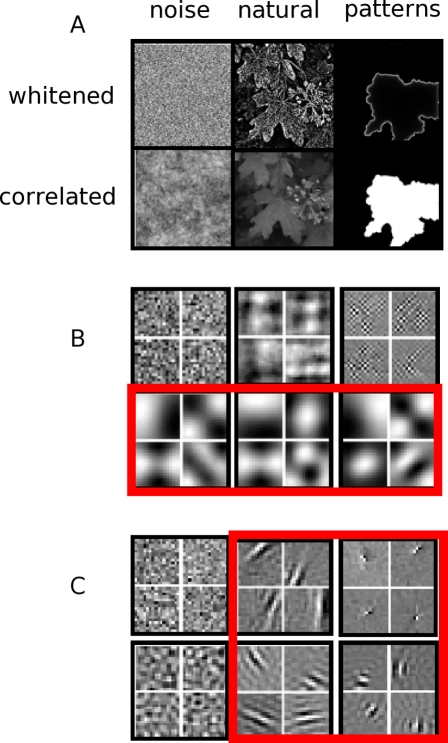
Information relevant to filter formation goes beyond simple, pairwise correlations.(A) Examples of training data for efficient coding. Whitened images were obtained by flattening an assumed 1/f slope in the Fourier amplitude spectrum. (B) PCA bases from each of the six data sets in (A). Note, algorithms which rely on pairwise correlations alone (also known as second order image statistics) only find structure for receptive field formation in correlated data [red rectangle] although much of the useful structure still visible in the decorrelated (“whitened”) images is not captured. Also note the receptive fields in this case are not localized. (C) Representative filters from the same image sets using ICA. Note that the filters from the whitened and unwhitened, natural and wavefront-patterned data qualitatively resemble receptive fields [red square], whereas unstructured 1/f noise does not produce equivalent filters - unlike the results of pairwise correlation-based measures. (note: differences in whitened ICA filter sizes are primarily a product of the 1/f assumption).